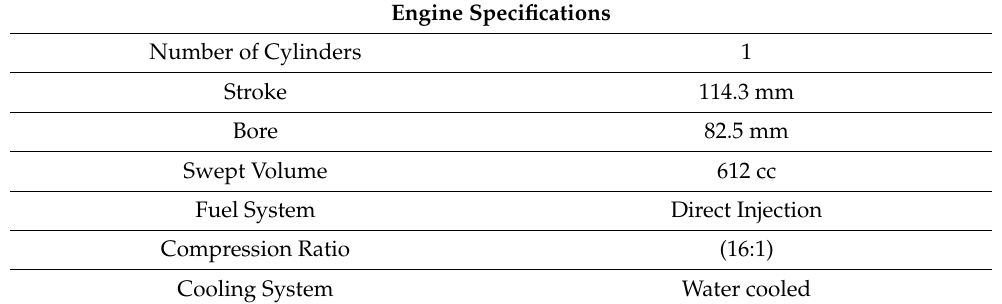
Figure 2. Schematic of experimental rig. Table 3. Engine Specifications.